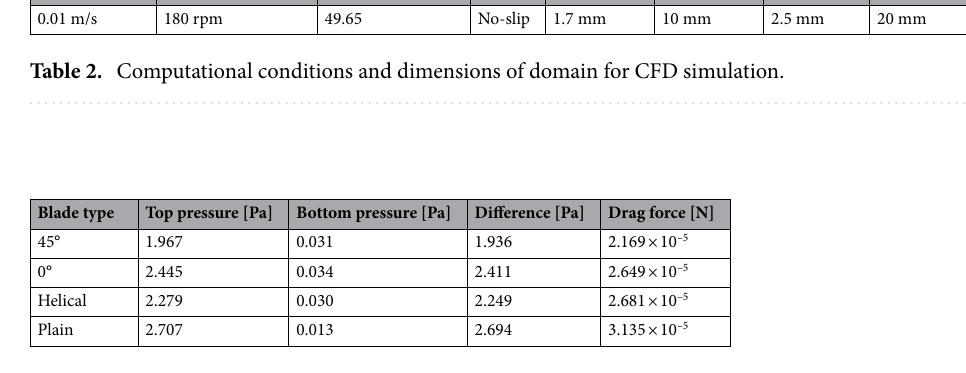
Table 3. Calculated pressure values at top head and bottom tail of each MDD and drag force.